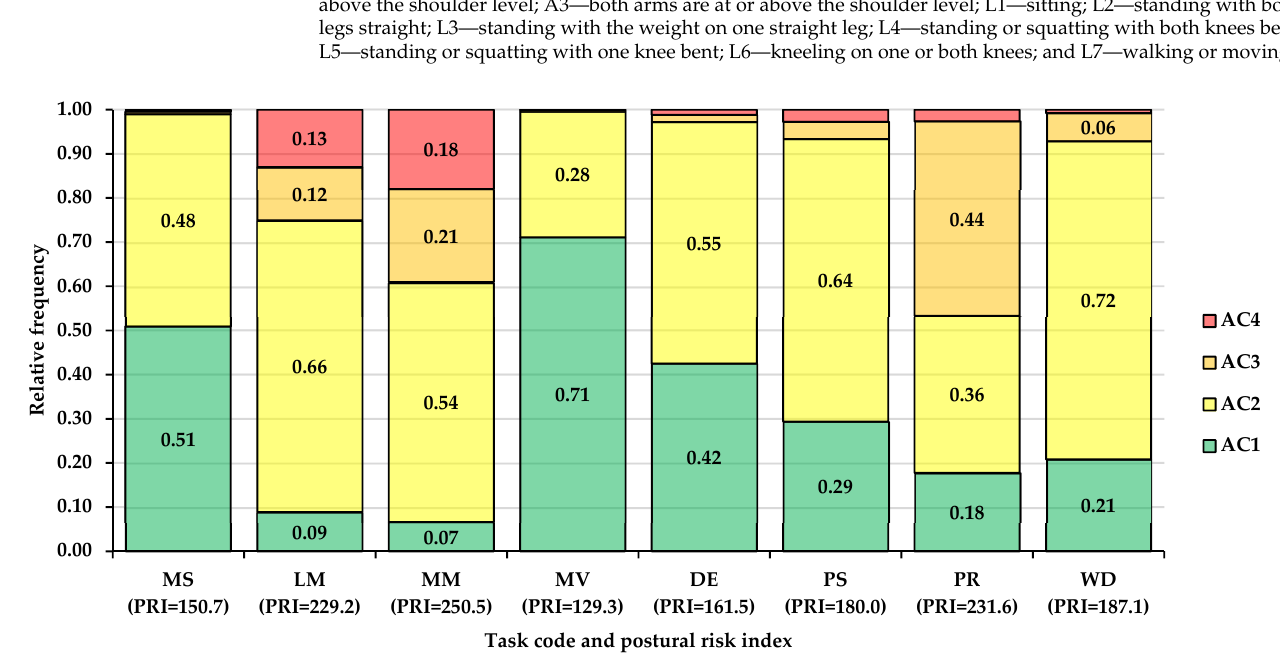
Figure 2. Share of action categories on tasks and postural risk indexes. Legend: MS—scanning by the mobile laser scanner; LM—marking the logs by paint; MM—measuring manually the diameters; MV—moving; DE—delays; PS—scanning by the smartphone; PR—preparing the tasks; WD—writ- ing data on a field book; AC1—first action category, no corrective actions needed; AC2—second